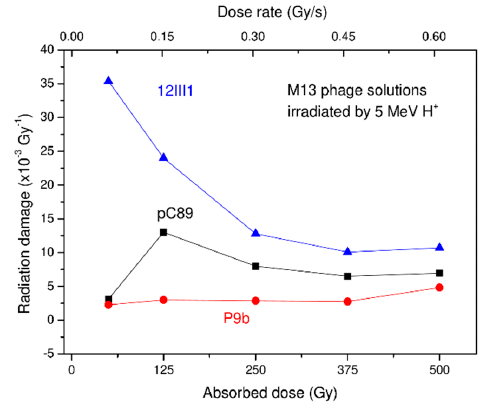
Figure 4. Radiation damage (RD) for each phage as a function of absorbed proton dose and the dose rate.